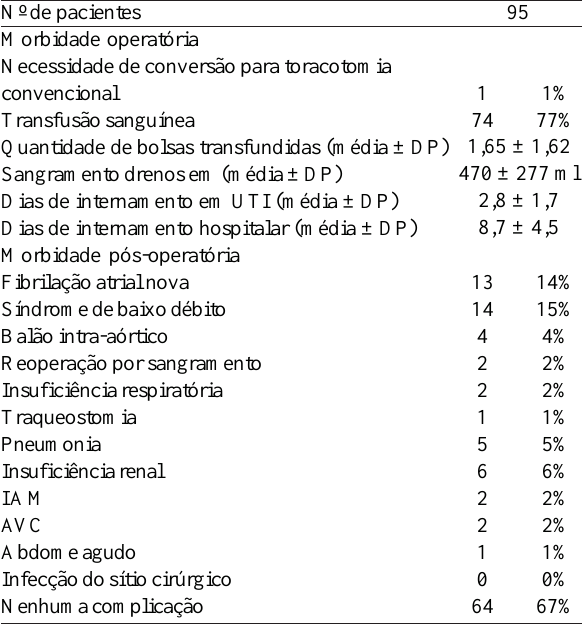
Tabela 5. Morbidade operatória e pós-operatória em 95 pacientes submetidos a operações minimamente